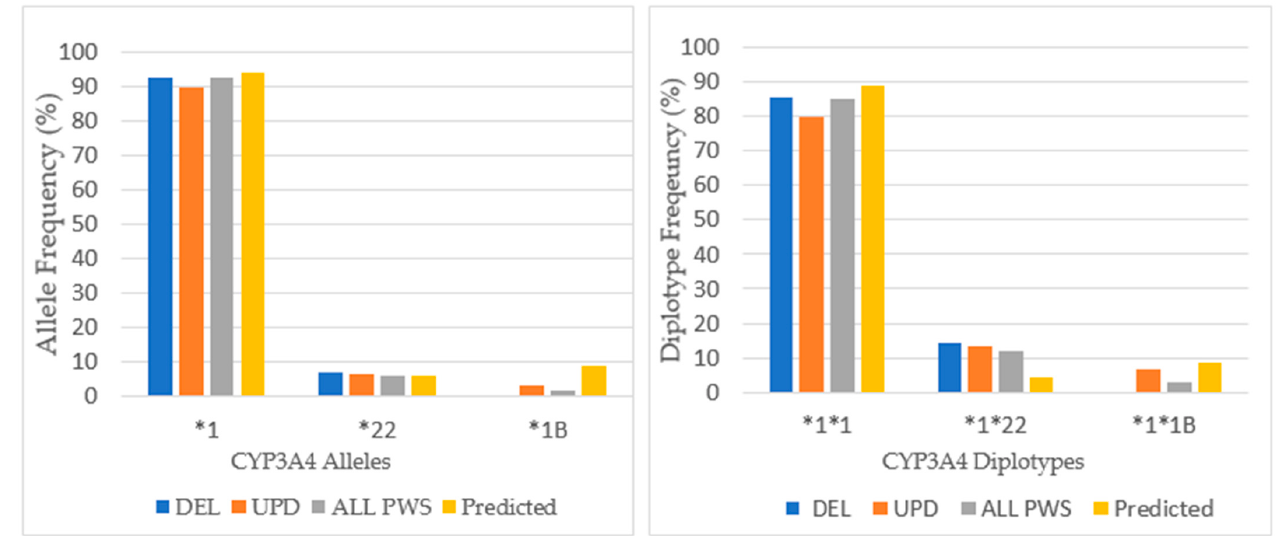
Figure 10. CYP3A4 allele and diplotype frequencies among PWS DEL ( n = 14), UPD ( n = 15), and combined cohort (ALL PWS, n = 34) compared to Caucasian normative, predicted data [33,34].